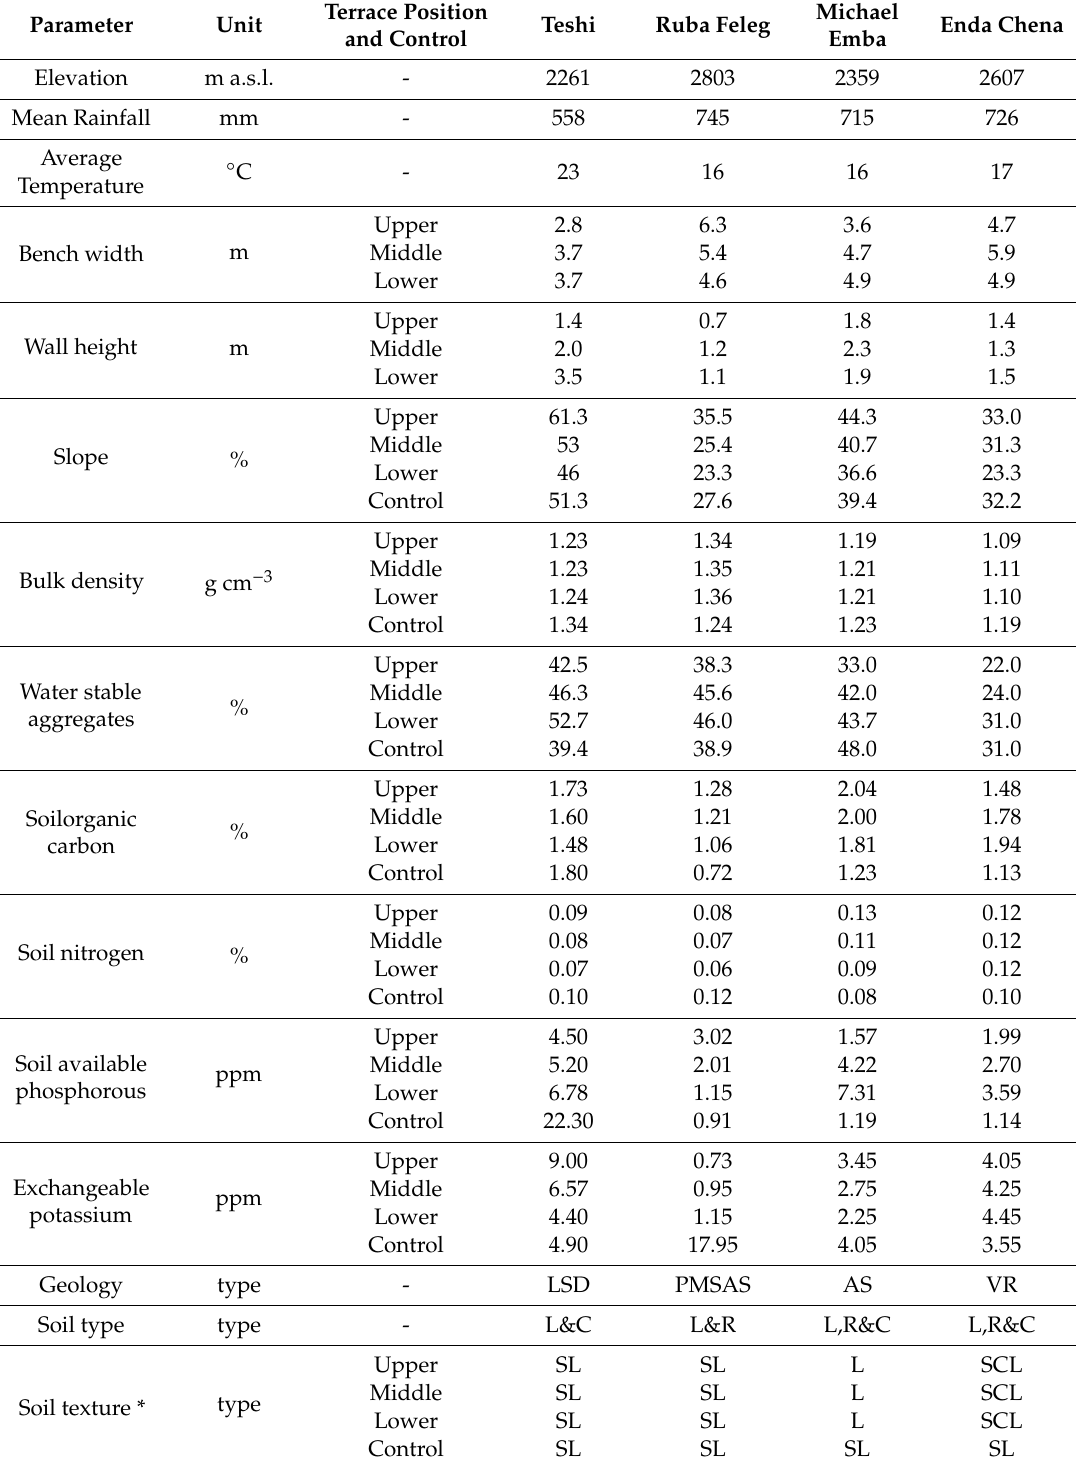
Table 1. Characteristics of the hillside farming positions and adjacent control sites, where: LSD = Limestone with some dolerite, PMSAS = Precambrian meta-sediment and Adigrat Sandstone, AS = Adigrat sandstone, VR = volcanic rock, L = Leptosols, C = Cambisols, R = Regosols, SL = silt loam, L = loam, SCL = sandy clay loam. For further detail, refer to reference